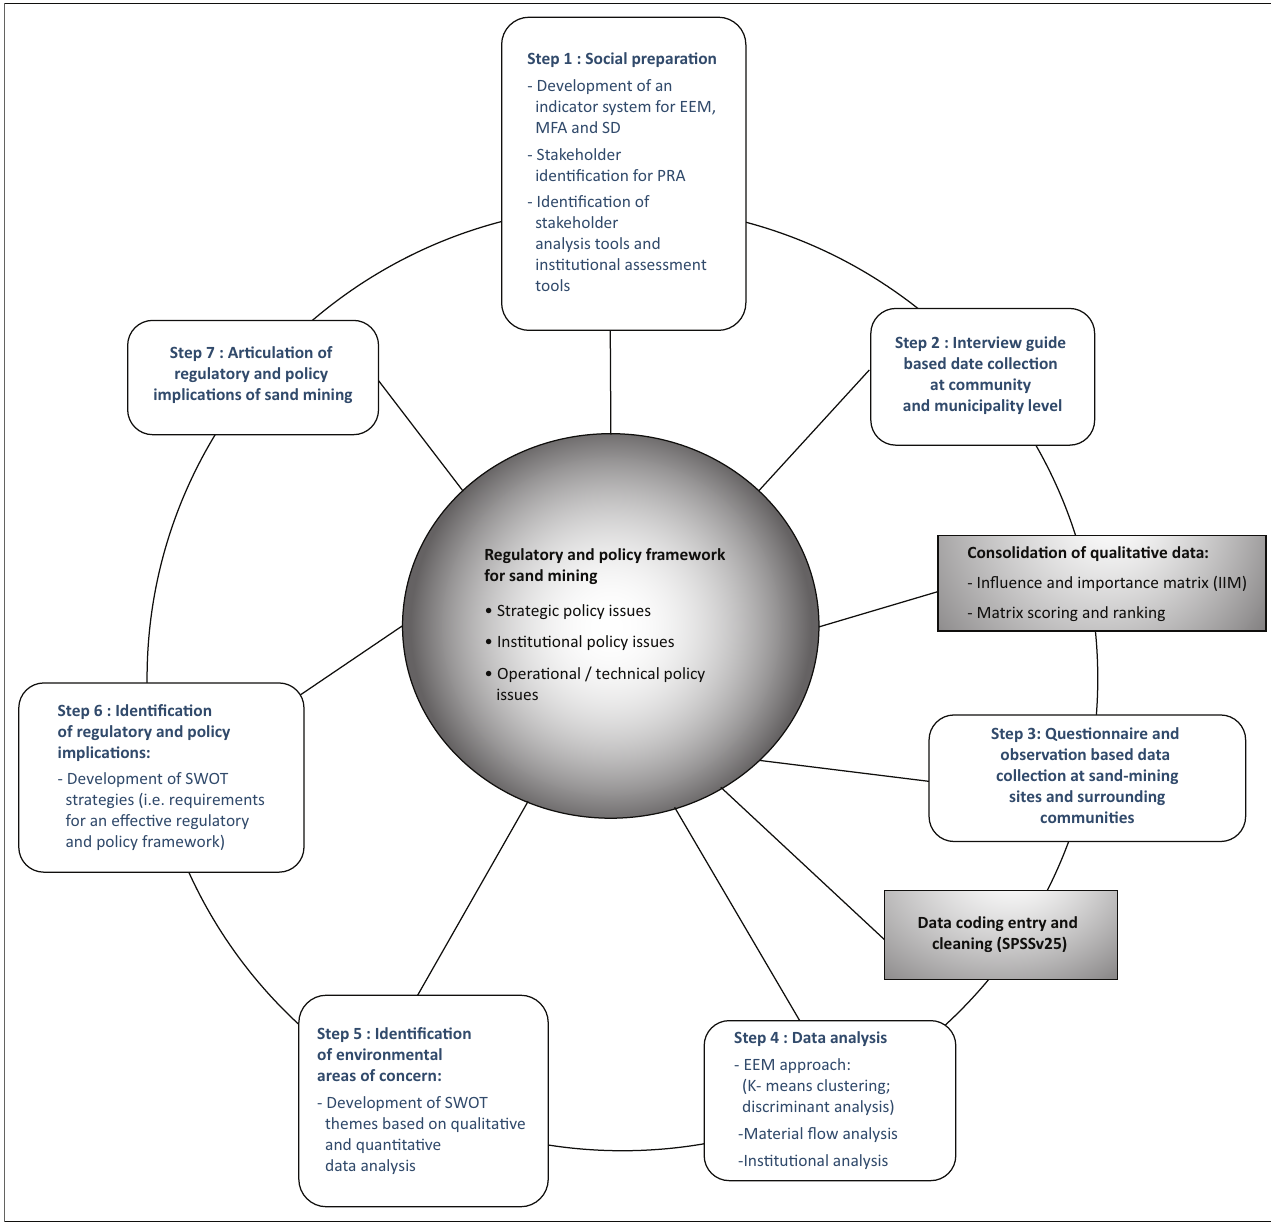
FIGURE 2: Adopted research